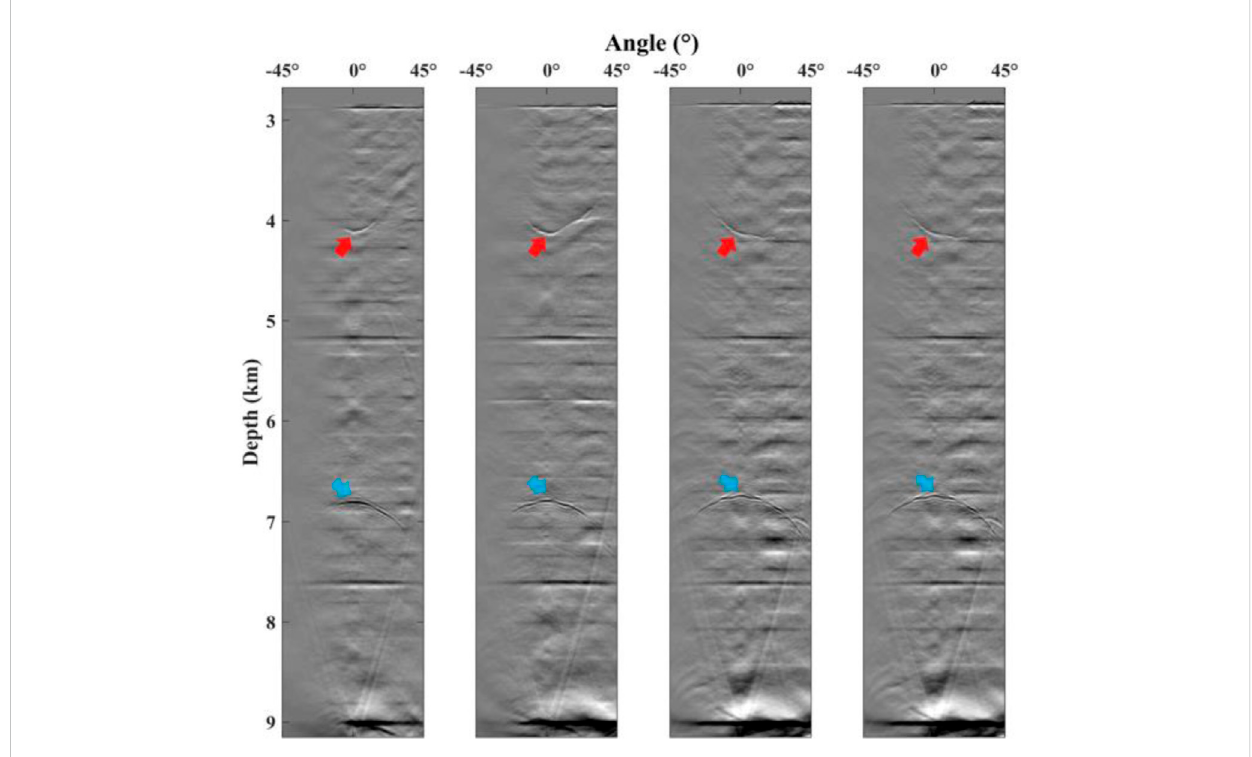
FIGURE 13 Angle gathers after migration. The red arrows and light blue arrows mark the locations where the anti-causal crosstalk and the causal crosstalk are located,